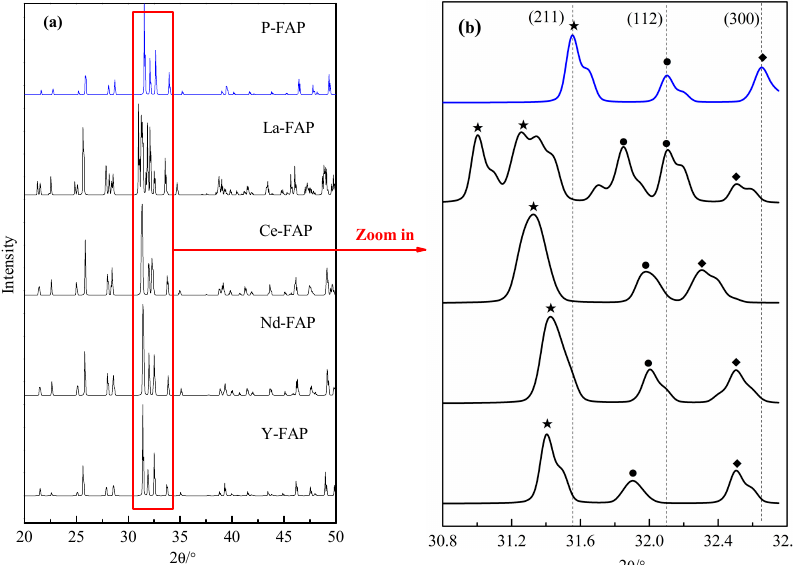
Figure 3. XRD patterns of perfect and REE-bearing fluorapatite crystals by Material Studio: ( a ) long-range pattern, ( b ) short-range pattern. ( ★ , ● and ◆ represent (211), (112) and (300) planes, respectively.).